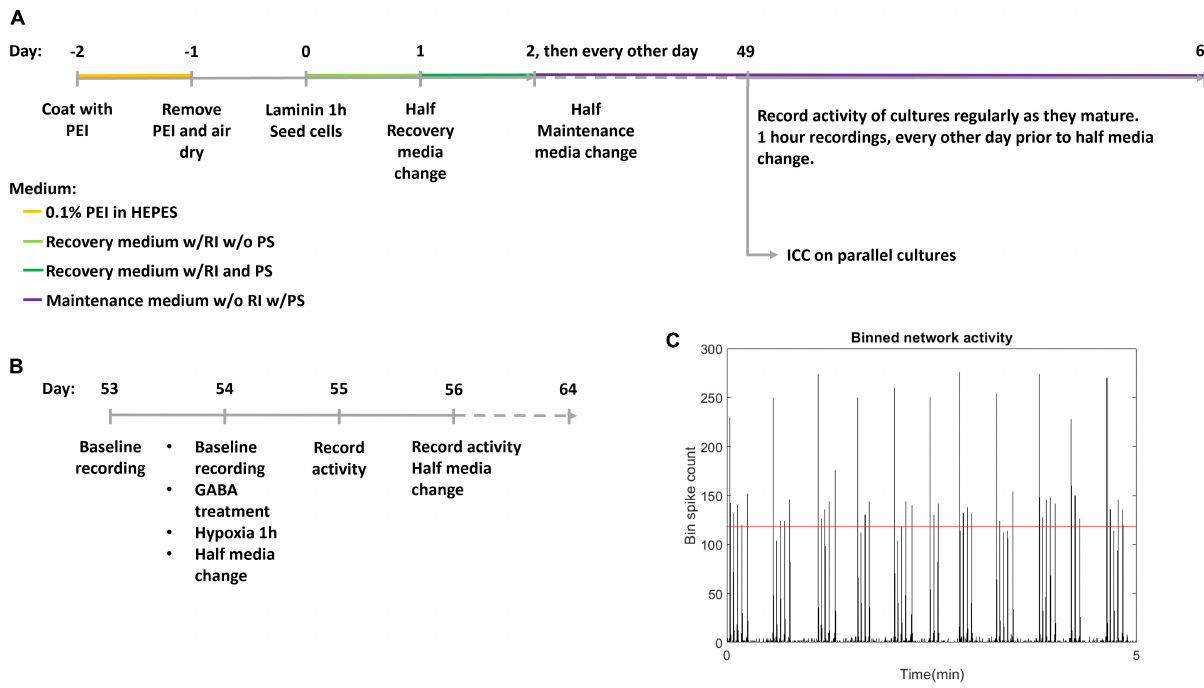
Frontiers in Integrative Neuroscience |